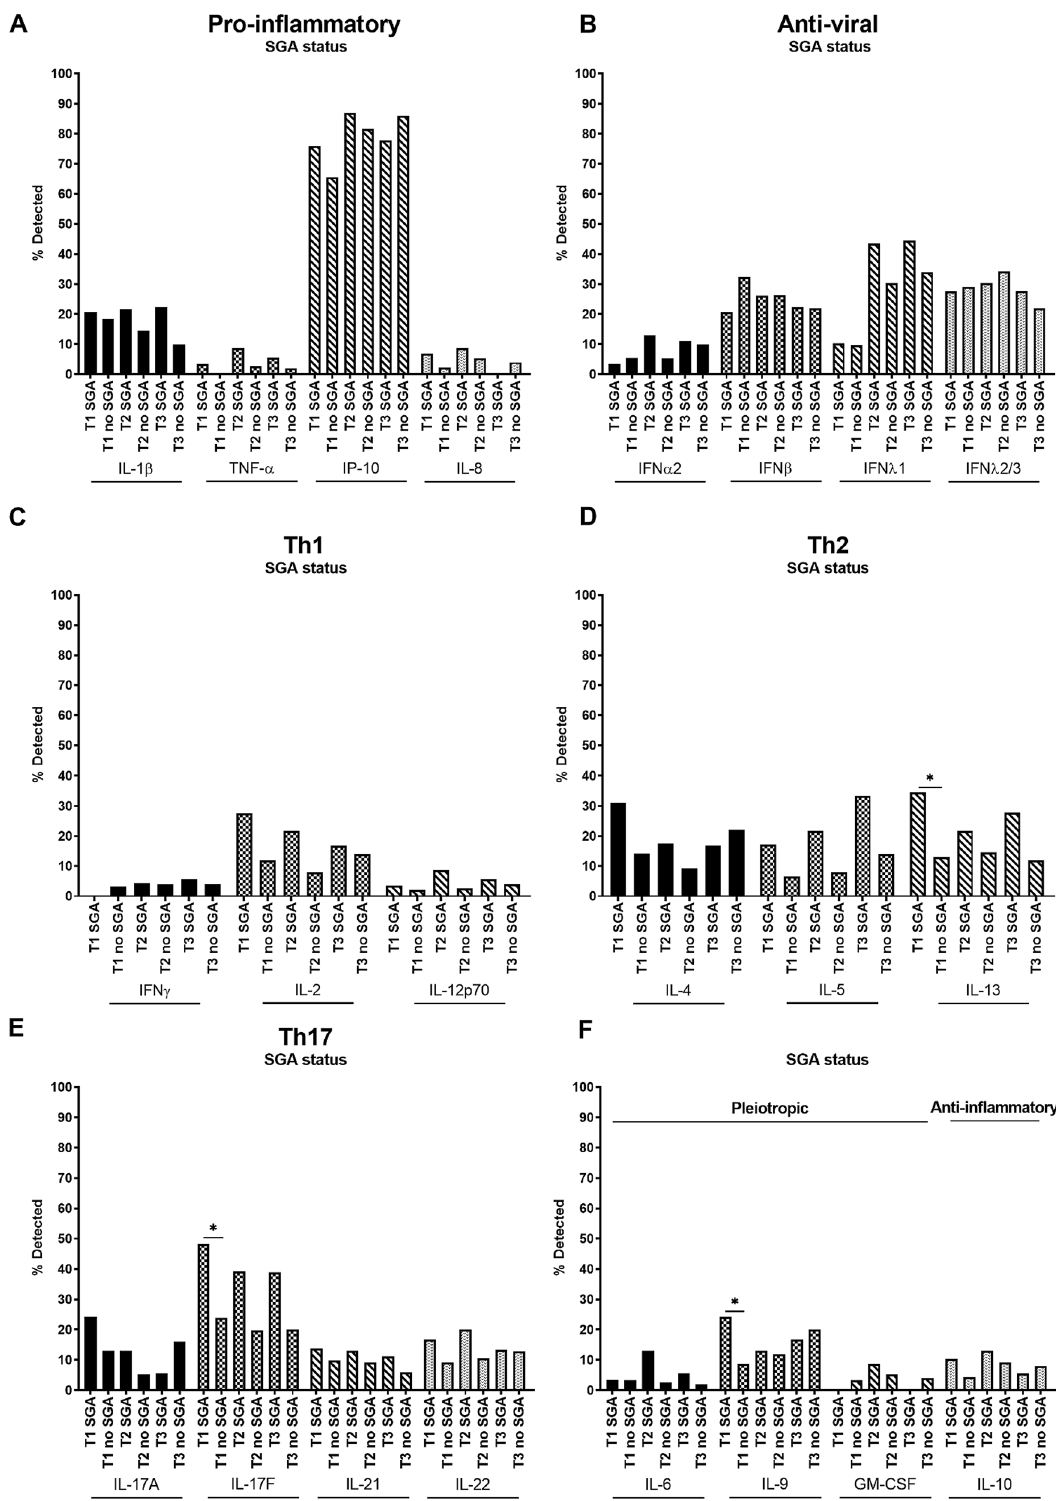
Figure 5. Systemic cytokines across pregnancy in women who went on to deliver small-for-gestational-age (SGA) infants versus women who delivered non-SGA infants. ( A ) Pro-inflammatory (IL-1β, TNF-α, IP-10, IL-8), ( B ) anti-viral (IFNα2, IFNβ, IFNλ1, IFNλ2/3), ( C ) Th1 (IFNγ, IL-2, IL-12p70), ( D ) Th2 (IL-4, IL-5, IL-13), ( E ) Th17 (IL-17A, IL-17F, IL-21, IL-22) and ( F ) pleiotropic and anti-inflammatory (IL-6, IL-9, GM-CSF and IL-10 respectively) cytokines were measured in maternal plasma collected during the first (T1), second (T2) and third (T3) trimester. Data are presented as the percentage of samples in which cytokines were detected by multiplex cytokine assay. *P <